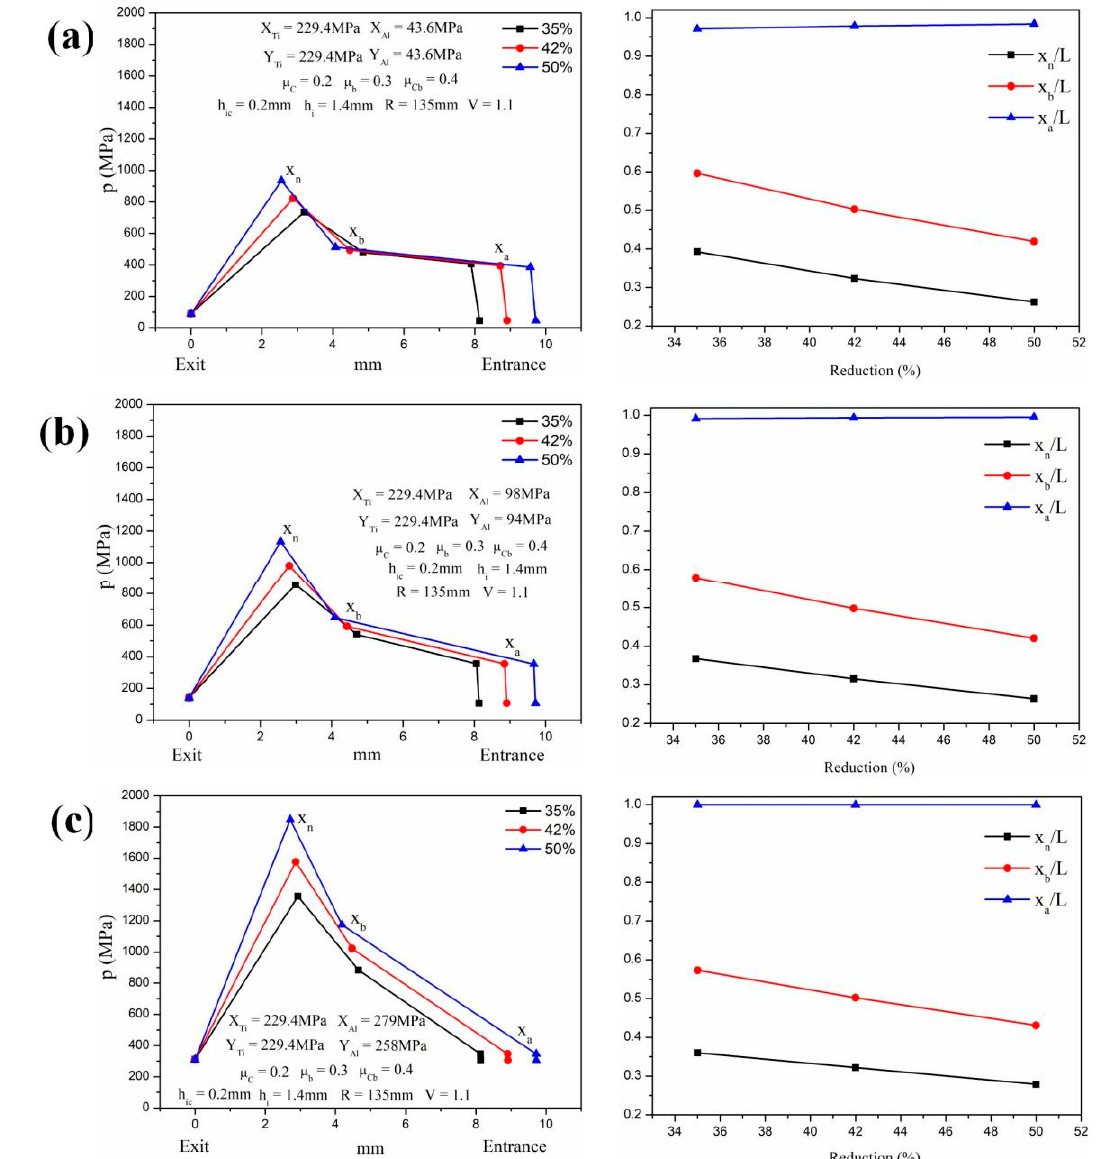
x , x and x , in the deformation a b n